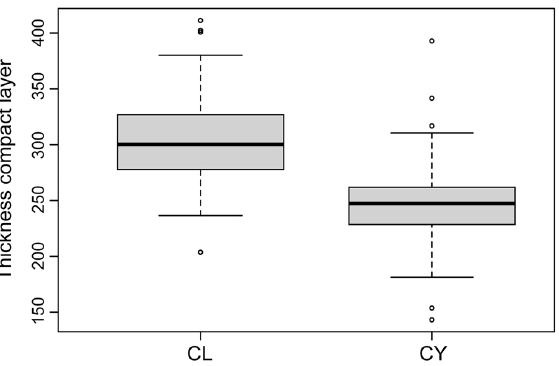
Figure 5. Comparison of the thickness of the compact region of the eggshell in C. latirostris and C. yacare . Mean values are 303.65 ± 4.56 µm (mean ± SE) and 246.10 ± 1.71 µm,